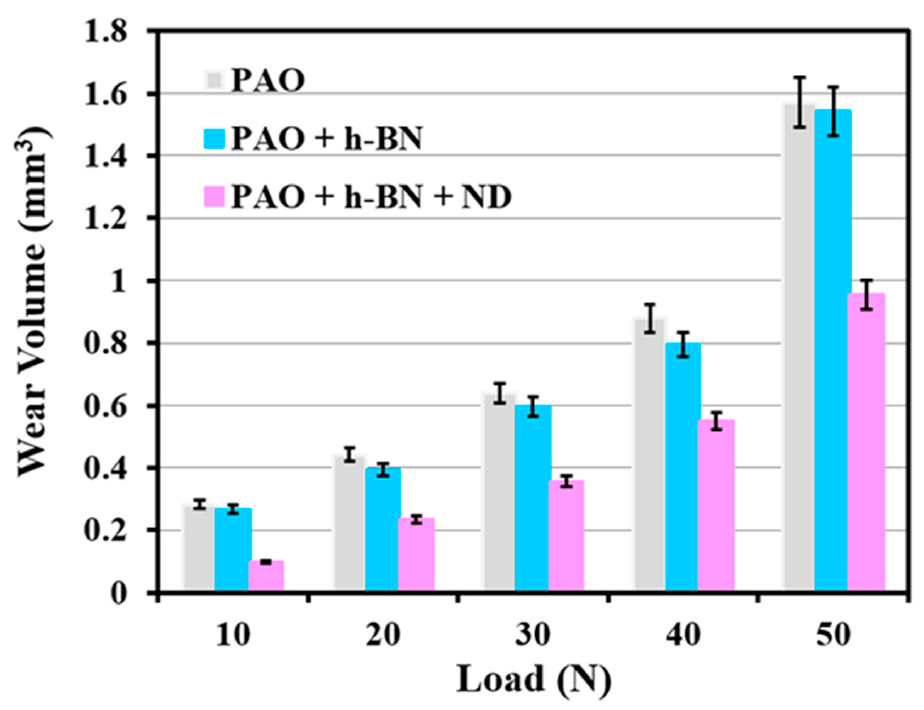
Figure 3. Wear volume of Al alloy discs (mm 3 ) in the presence of PAO base oil, PAO + h-BN and PAO + h-BN + ND nanolubricants, with increase in applied load from 10 N to 50 N.